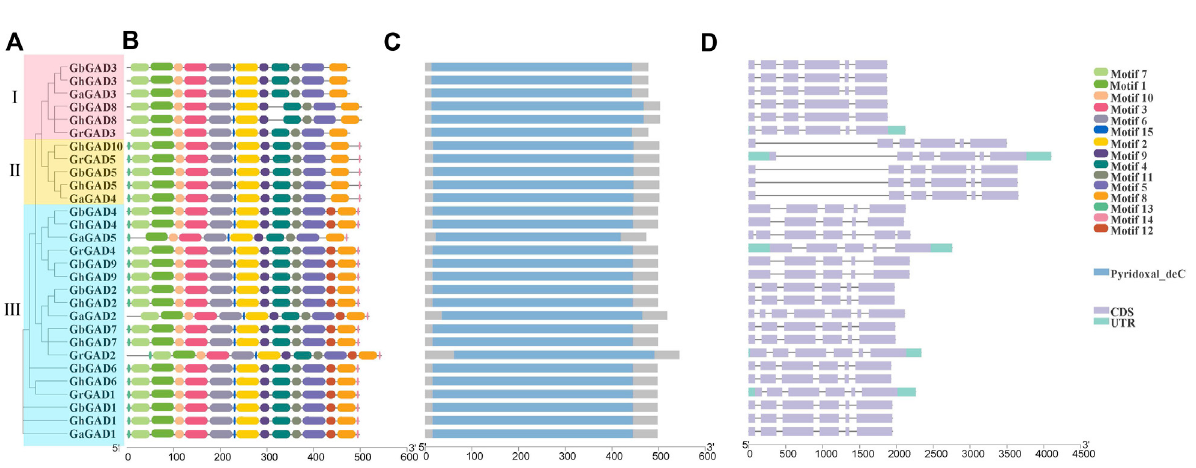
FIGURE 3 Conservative motifs, domain, and exon-intron organization of GAD gene family from G. hirsutum , G. barbadense , G. raimondii, and G. arboreum . (A) Phylogenetic tree of GAD gene family obtained according to NJ method in MEGA software. (B) Conservative motifs of GAD proteins. The motif information was obtained from the MEME webpage and visualized in TBtools. (C) Conservative domain of GAD proteins. (D) Exon – intron structures of GAD gene